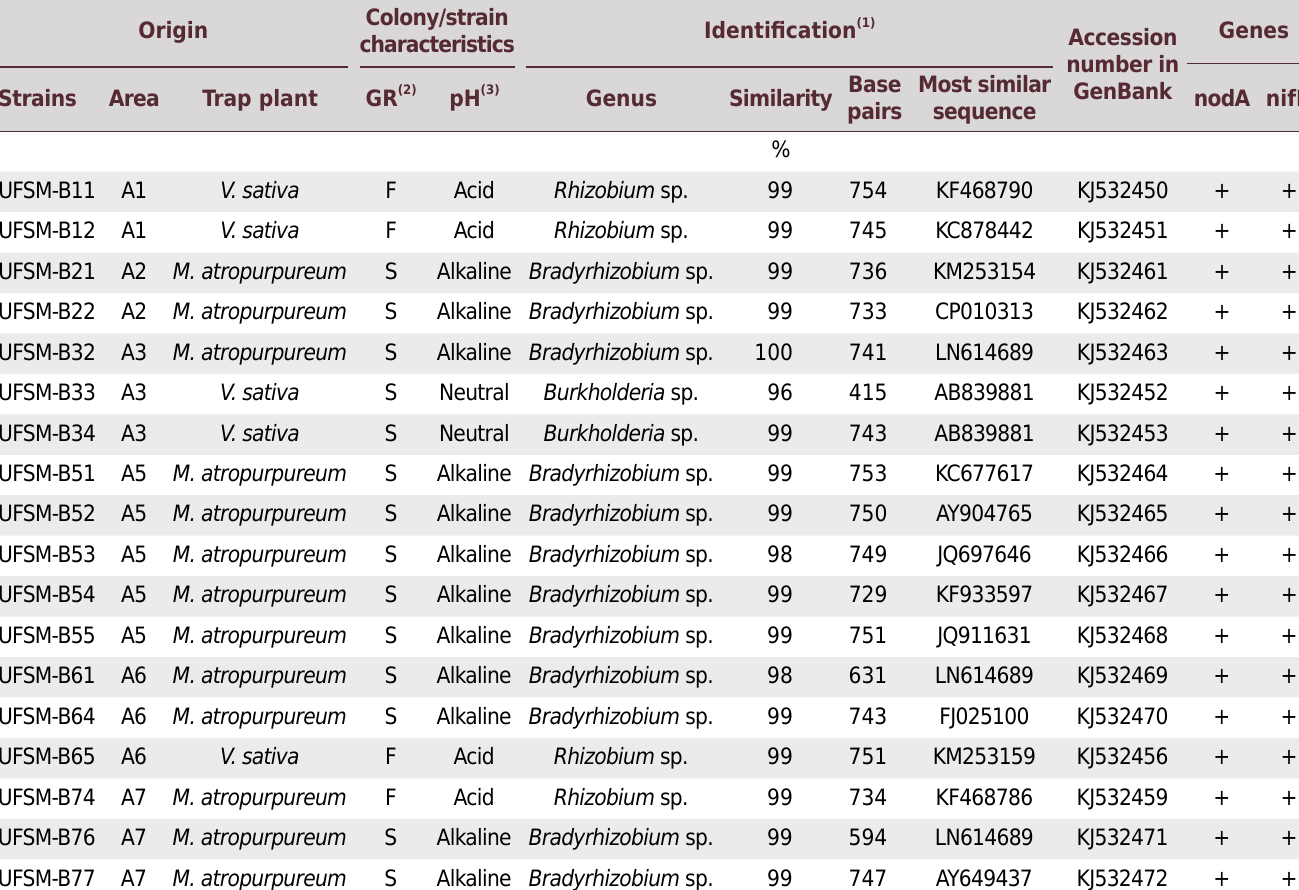
Table 4. Origin, characteristics, and identification of bacterial isolated strains obtained from nodules of Macroptilium atropurpureum and Vicia sativa cultivated in the coal-mining region of Candiota, RS-Brazil